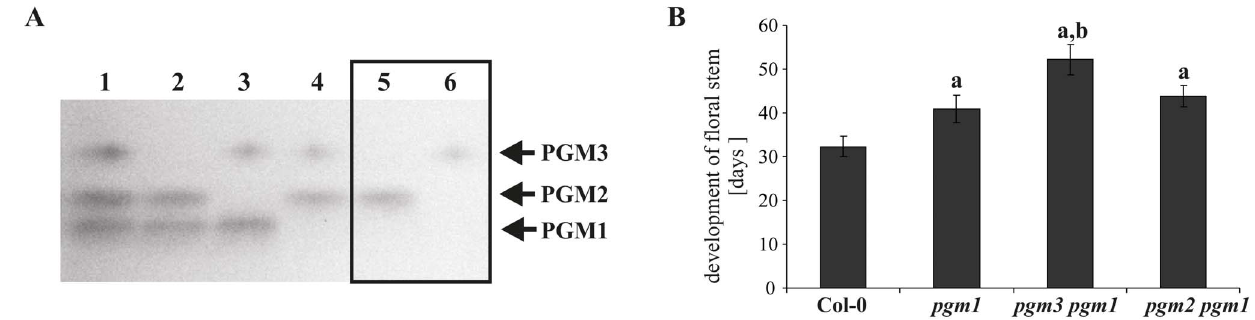
Figure 5. Characterization of knock-out mutants lacking one cytosolic and the plastidial PGM. A, Analysis of PGM activity in the Col-0 and pgm3 pgm1 and pgm2 pgm1 mutants using native PAGE and PGM activity staining. Separation gel 7.5% [T]. 35 m g proteins were loaded per lane. 1– Col-0, 2– pgm3 , 3– pgm2 , 4– pgm1 , 5– pgm3 pgm1 , 6– pgm2 pgm1. B, Analysis of floral stems development in Col-0 and different PGM knock-out plants. Plants were grown under long day conditions (14 h light/10 h dark). Days after germination were registered, when plants developed floral stems 1 cm long. Values are means 6 SD (n=24). a - significant difference from Col-0 (Student Test, p # 0.01), b - significant difference from pgm1 (Student Test, p #